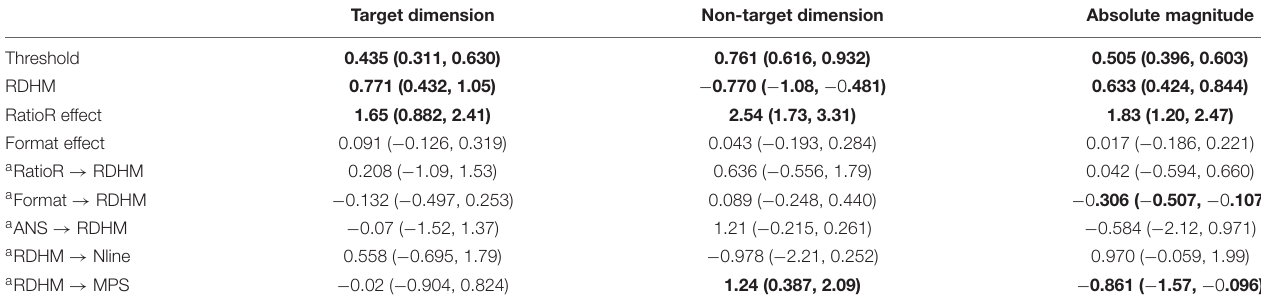
TABLE 3 | Unstandardized parameter estimates (and 95% Bayesian CI) of the unidimensional